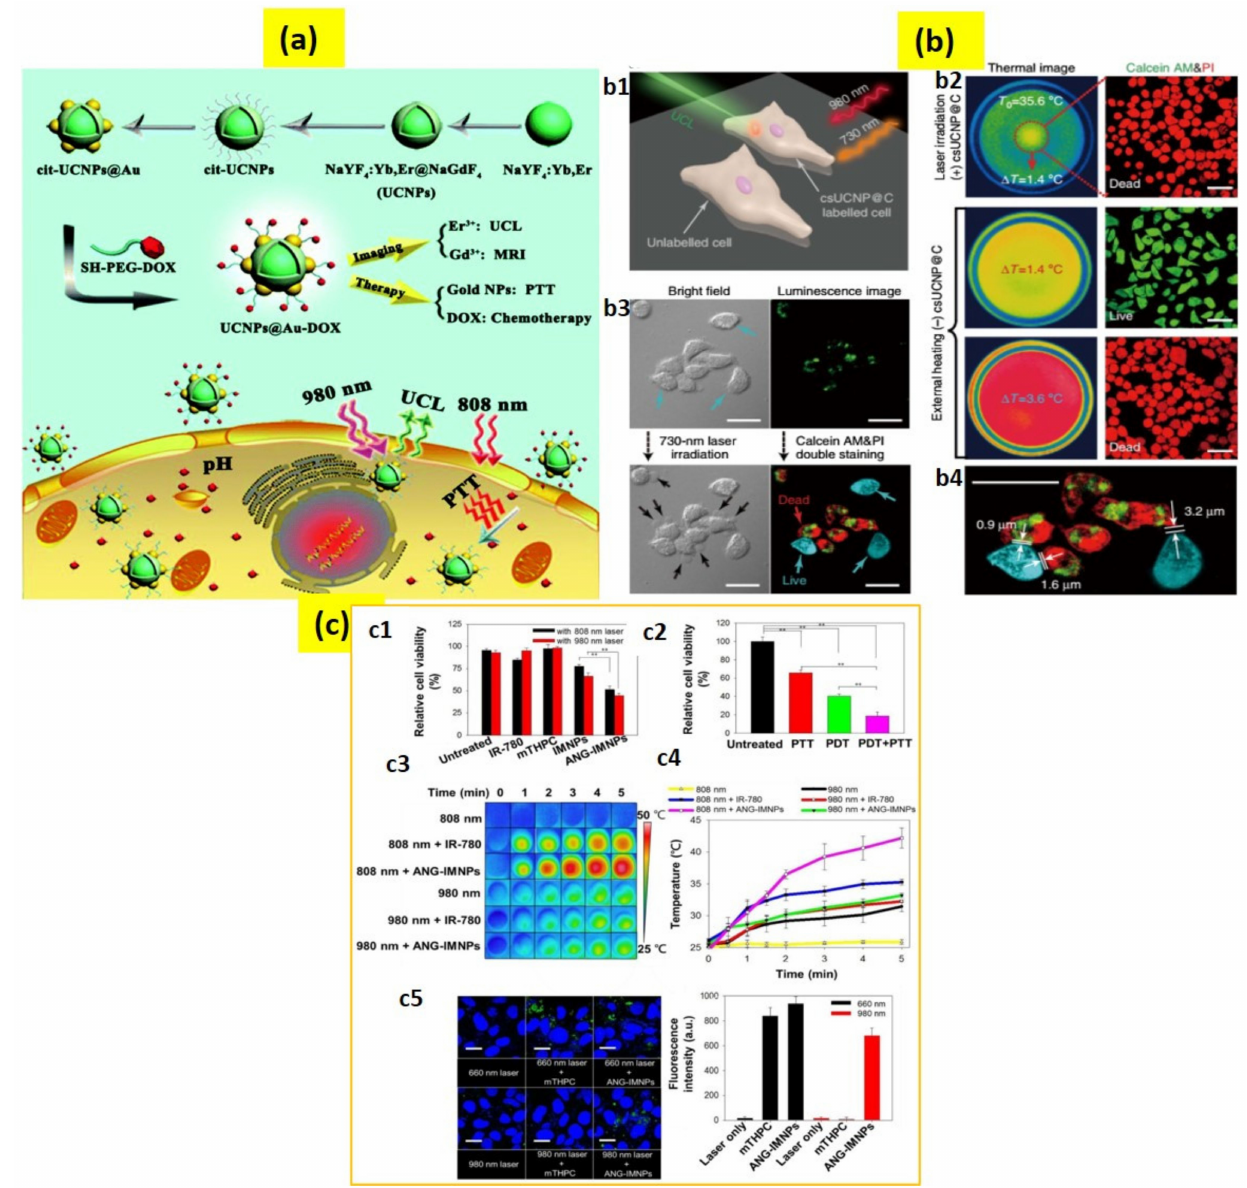
Figure 5. ( a ) Schematic presentation of the UCNPs@Au-DOX synthesis, luminescence (UCL)/magnetic resonance (MR) imaging, photothermal therapy (PTT), and chemotherapy. ( b ) High-accuracy PTT using csUCNP@C. ( b1 ) Schematic illustration of PTT. ( b2 ) Images of HeLa cells with photothermal ablation ( b3 ) PTT of HeLa cells upon 730 nm light excitation for 5 min. csUCNP@C-labeled cells exhibited a strong upconversion signal in the cytoplasm (green). ( b4 ) Amplified image of ( b3 ). ( c ) PDT/PTT effects on ALTS1C1 cells. ( c1 ) Cytotoxicity of mTHPC, free IR-780, IMNPs, and ANG-IMNPs upon 808 nm or 980 nm laser light. ( c2 ) Cytotoxicity of PTT and PDT; symbols and error bars are mean ± S.D. ** p < 0.01. ( c3 ) Thermal images and ( c4 ) temperature rise profiles upon irradiation. ( c5 ) Laser scanning confocal microscopy images and the corresponding quantitative comparison of in vitro ROS generation in ALTS1C1 cells; singlet oxygen sensor green staining shown in green; blue shows cell nuclei stained with DAPI; scale bar: 20 µ m. The 660 nm light generated due to upconversion reaction of the NIR laser inside the cancer cells, increasing fluorescence intensity. Adapted with permission from